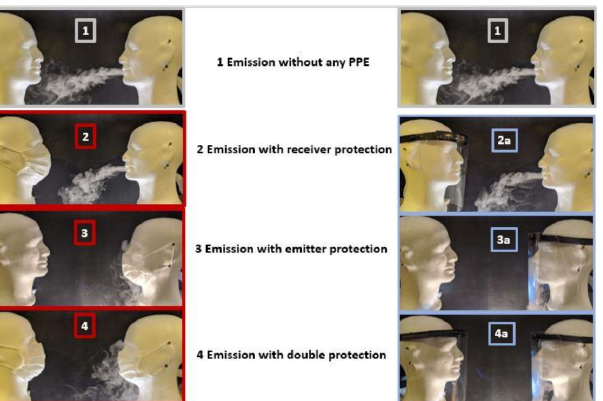
Figure 3. Experimental configurations: 1: emission without any personal protective equipment (PPE); 2: emission with mask for Receiver protection; 2a: emission with face shield for Receiver protection; 3: emission with mask for Emitter protection; 3a: emission with face shield for Emitter protection; 4: double protection with masks for Emitter and Receiver; 4a: double protection with face shields for Emitter and